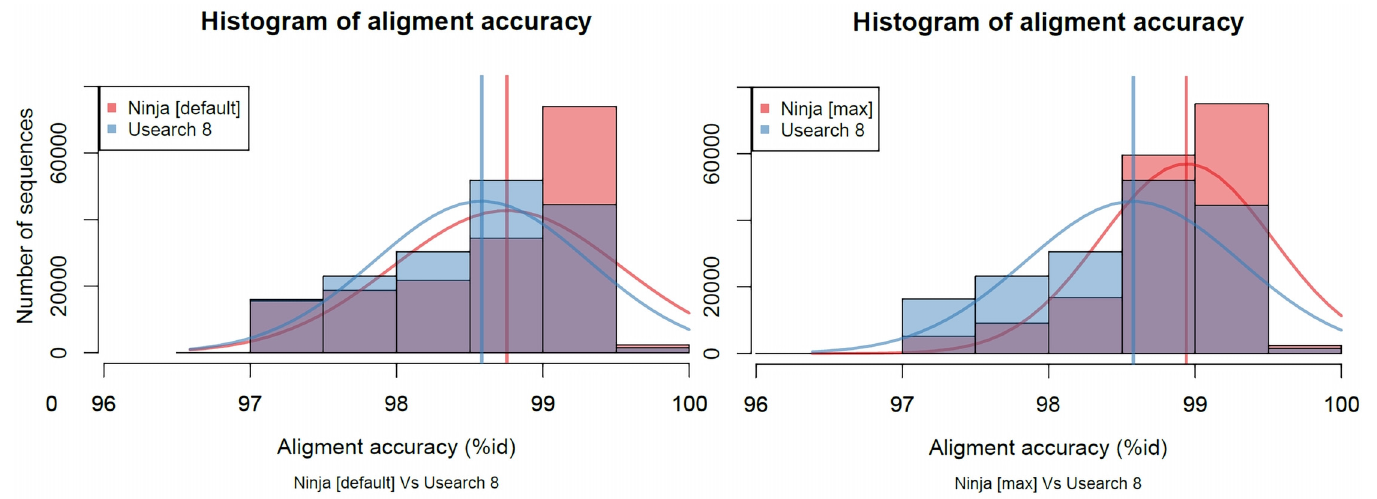
Fig 3. Comparison of NINJA and USEARCH 8 best match accuracy using all unique matches. These histograms show the distribution of matches by algorithm, where NINJA match proportion is in red, USEARCH in blue, and the overlap in purple. The right-most bars in each histogram show more red than purple, indicating NINJA aligned more reads at higher accuracy than USEARCH in the corresponding bins. The thick vertical bars correspond to the average alignment accuracy, and the thin curves represent the interpolated distribution. A Student ’ s t-test on the mean alignment accuracy shows NINJA ’ s mean ID was 98.9%, while USEARCH 8 produced 98.7% with p-value < 2.2e-16. For USEARCH 8, fast settings are used (corresponding to the defaults in the QIIME pipeline). Total number of unique sequences mapped are 168,761, 170,063, and 169,313, for NINJA [default], NINJA [max], and USEARCH 8, respectively.